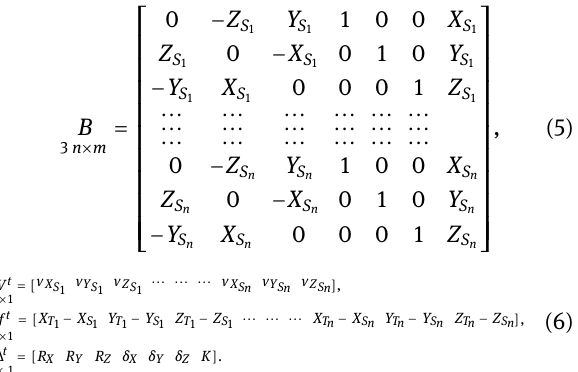
Figure 4: Bursa – Wolf algorithm of the datum